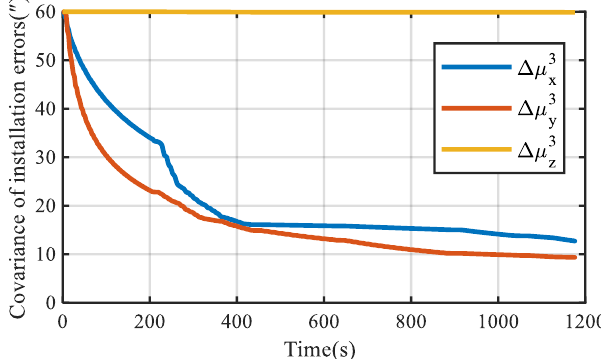
Figure 13. Experimental results of installation errors’ covariance.